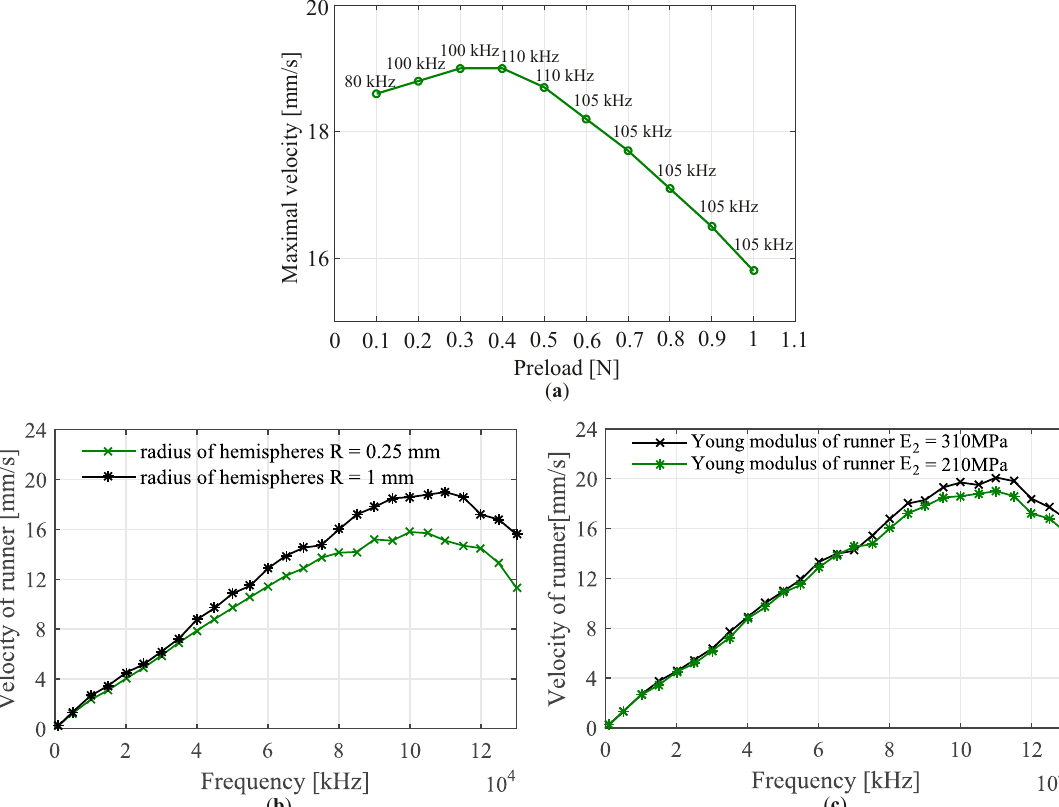
Figure 10. Influence of important parameters on velocity of the runner: ( a ) influence of the preload; ( b ) influence of the radius of the hemispheres; ( c ) influence of Young’s modulus of the runner’s material (simulation